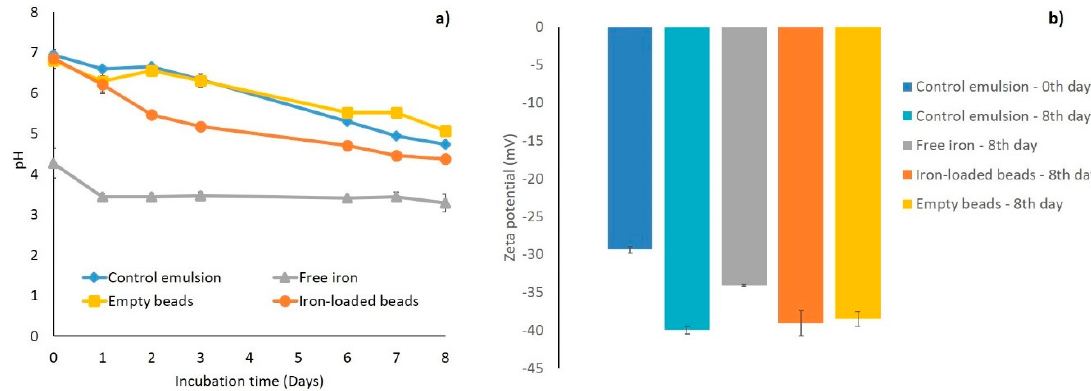
Figure 3. ( a ) pH of the control emulsion ( (cid:7) ) and of emulsions with free iron ( (cid:78) ), iron-loaded alginate beads ( (cid:8) ), and empty alginate beads ( (cid:4) ); ( b ) Zeta potential of the control emulsion at day 0 and 8, and of emulsions with free iron, iron-loaded alginate beads, and empty alginate beads, after 8 days of incubation. All emulsions were incubated at 25 ◦ C under slow rotative agitation. In iron-containing emulsions, the total FeSO 4 concentration was 200 µ M. Error bars represent standard deviations ( n =